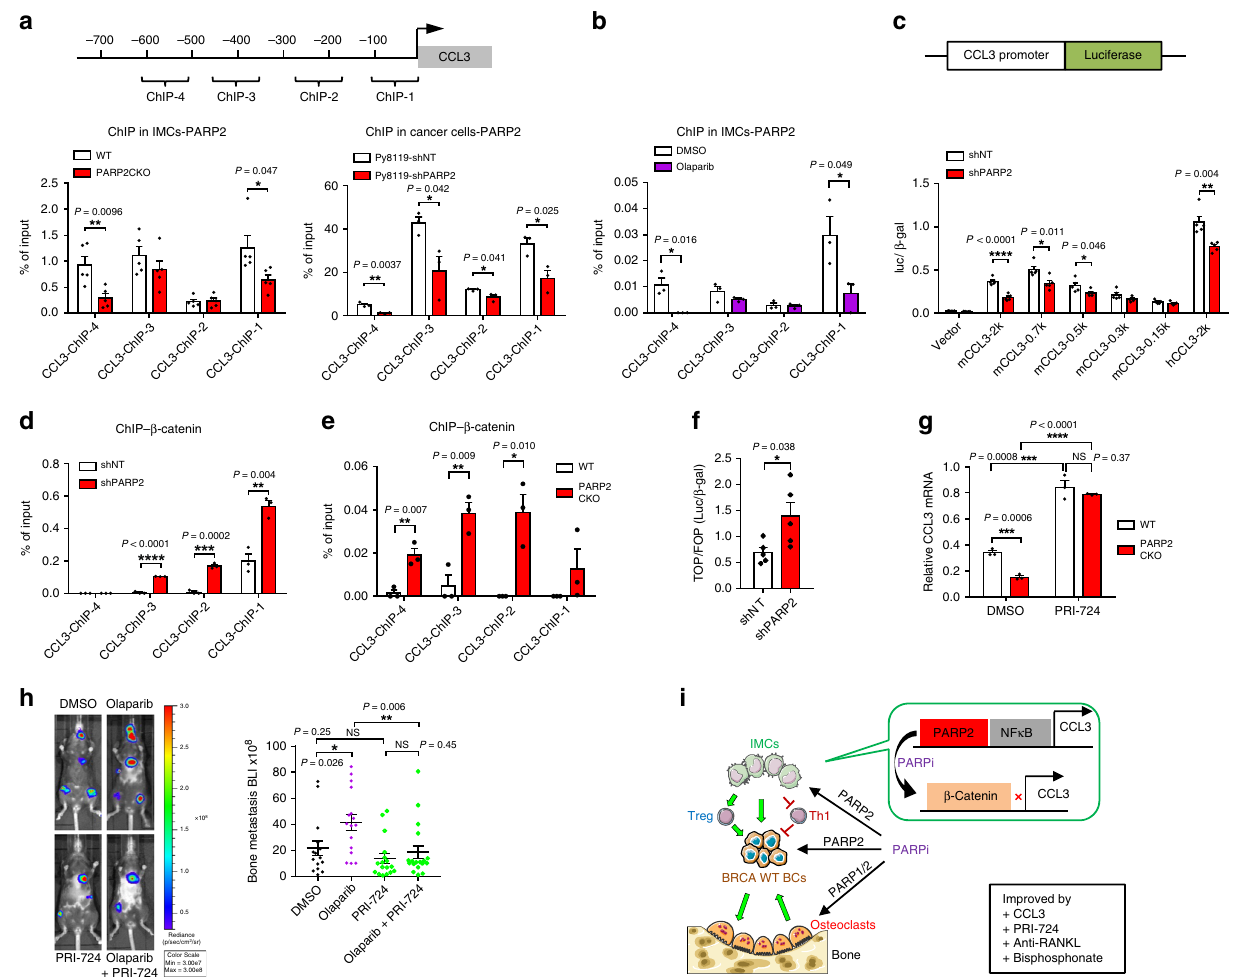
Fig. 4 Inhibition of β -catenin increases PARP2-dependent CCL3 expression and prevents olaparib-induced bone metastasis. a (Top) a diagram of primer locations at the promoter of CCL3 for chromatin immunoprecipitation (ChIP) analyses; (bottom) ChIP analyses showed that PARP2 associated with CCL3 promoter in IMCs (bottom left; n = 5) and Py8119 cells (bottom right; n = 3). b ChIP analyses showed that 3 μ M olaparib-suppressed PARP2 binding to CCL3 promoter in IMCs ( n = 3). c (Top) a diagram of CCL3 promoter-driven luciferase transcription in the CCL3-luc reporter system; (bottom) PARP2KD signi fi cantly impaired CCL3 promoter-driven luciferase expression ( n = 5) when CCL3 promoter included >0.5k bp regions upstream of transcription start site. d , e In ChIP, β -catenin binding to CCL3 promoter was increased in PARP2KD Py8119 cells ( d , n = 3) and PARP2CKO IMCs ( e , n = 3). f TOP/FOP fl ash assay revealed that PARP2 negatively regulate β -catenin transcriptional activity ( n = 5). g CCL3 expression was elevated in IMCs treated with 1 μ M β -catenin inhibitor PRI-724 for 3 days ( n = 3). h PRI-724 blocked olaparib-induced bone metastasis in B6 WT mice ( n = 16). i A model for how olaparib regulates breast cancer bone metastasis. BCs breast cancer cells, PARPi PARP inhibitor. Data represent mean ± SEM, * P < 0.05, ** P < 0.01, *** P < 0.001, **** P < 0.0001; NS nonsigni fi cant. Two-sided Student ’ s t -test was used to calculate statistical difference. Source data are provided as a Source Data fi